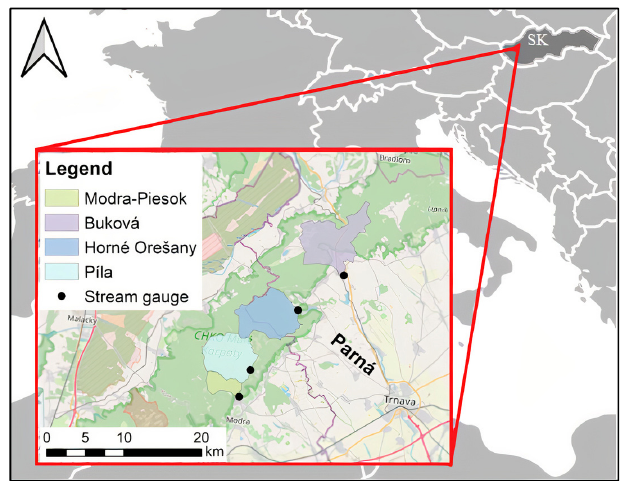
Figure 1. Location of selected catchments.